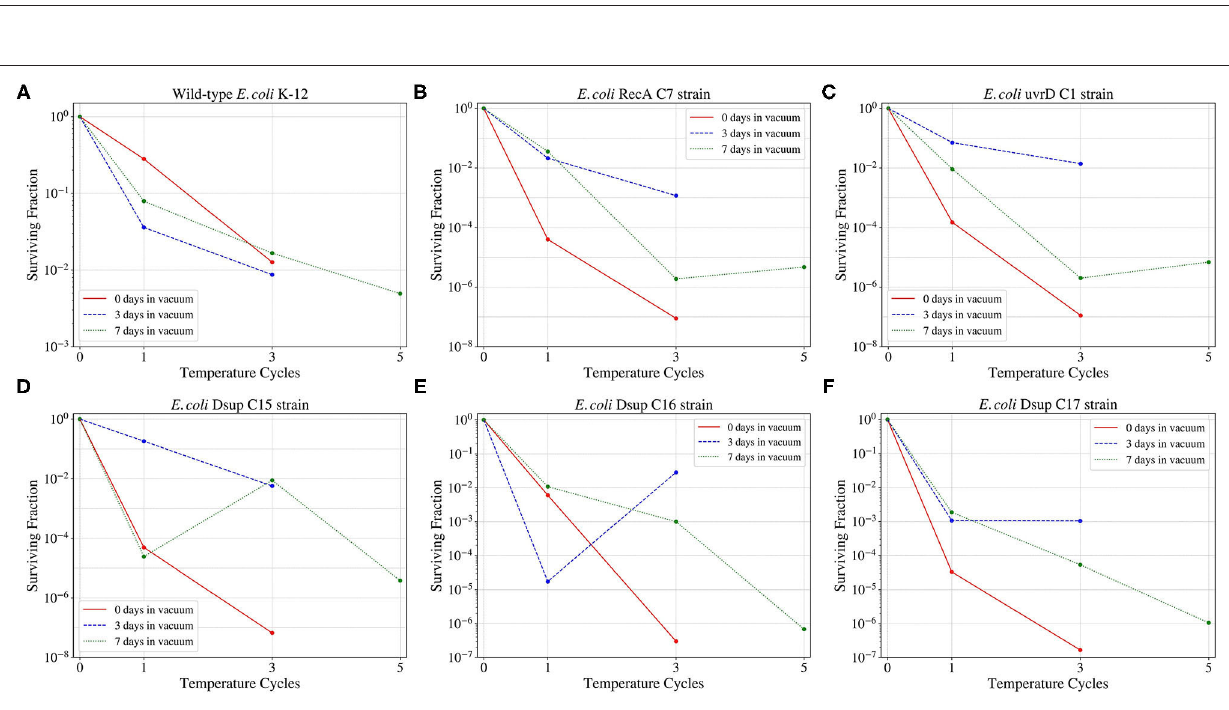
FIGURE 9 | Survival of the wild-type E. coli K-12 strain (A) and the different RecA (B) , uvrD (C) , and Dsup (D–F) selected colonies to the temperature cycles from –80 to 50 ◦ C after 0, 3, 7 days exposures to a ∼ 93%